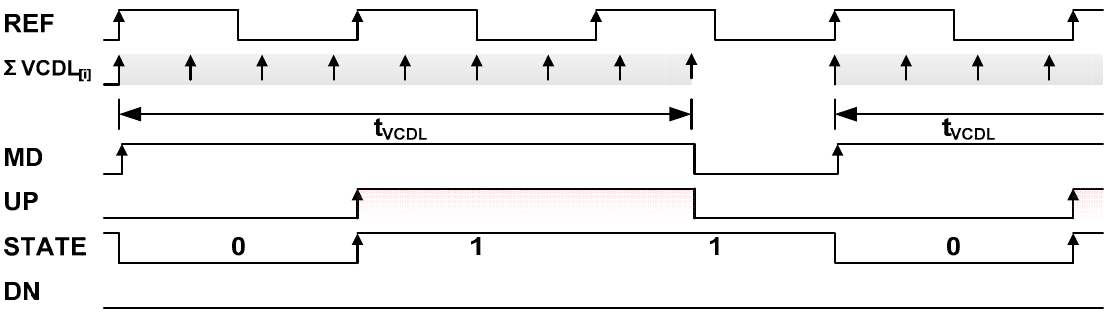
Figure 7. Timing diagram for the PD-MDV operation under the condition t VCDL > 2· t REF .